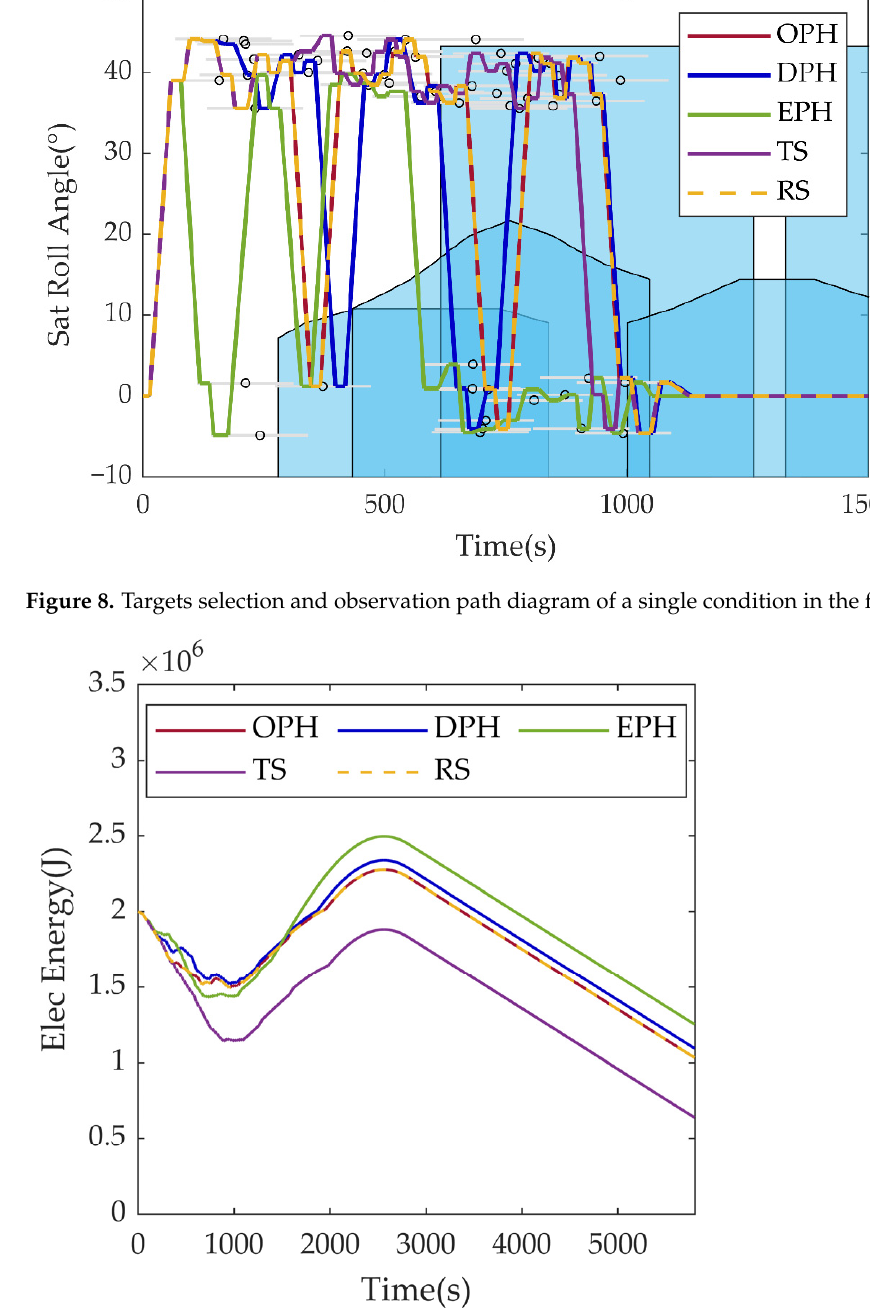
Remote Sens. 2023 , 14 , x FOR PEER REVIEW